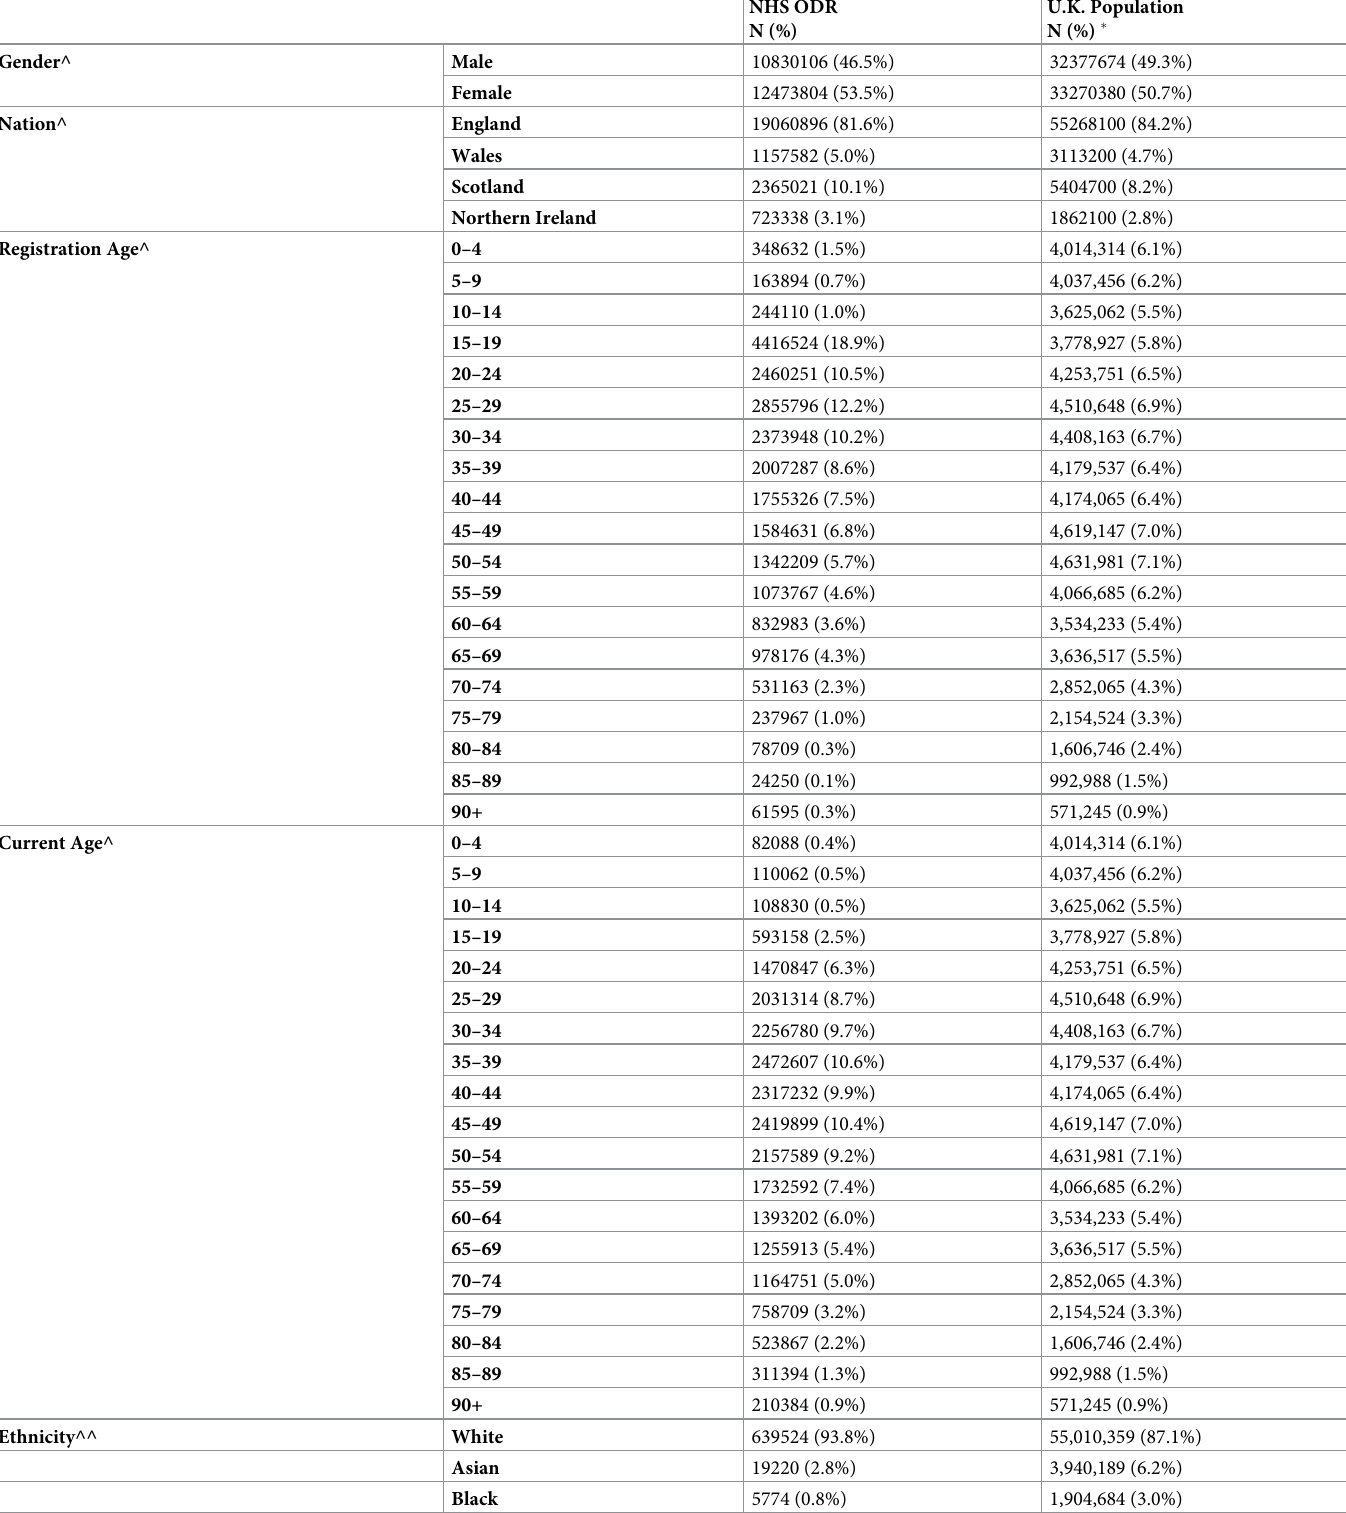
Table 1. Demographic distribution of NHS ODR compared with the U.K. general